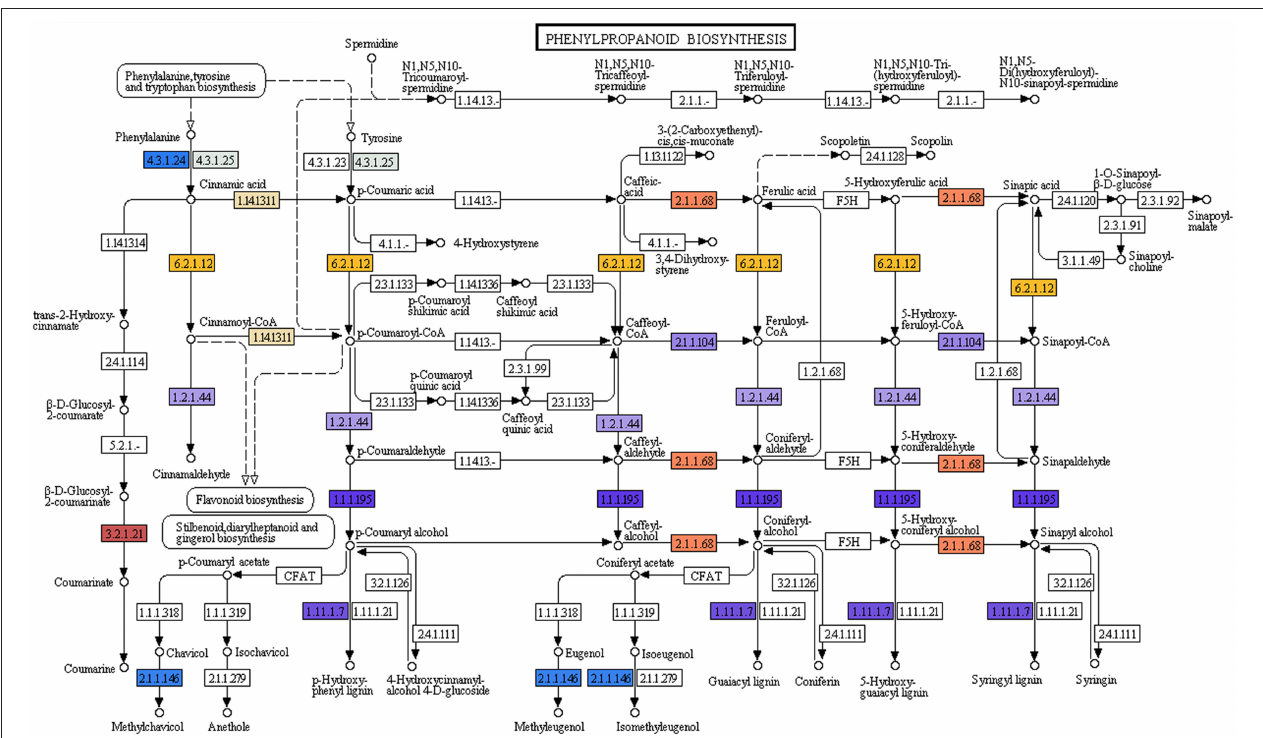
FIGURE 6 | Phenylpropanoid biosynthesis pathway study by KEGG analysis showing the different identified enzymes (one color for each Enzyme Code or EC).